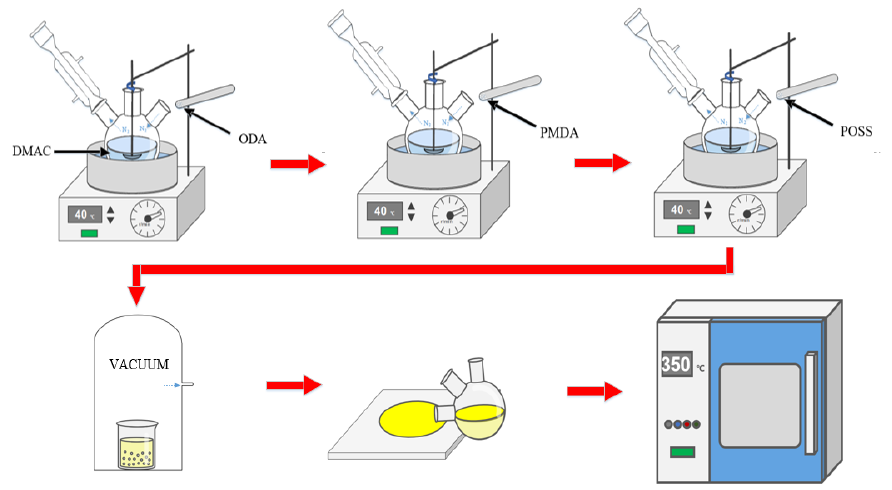
Figure 2. Preparation process of polyimide composite film.